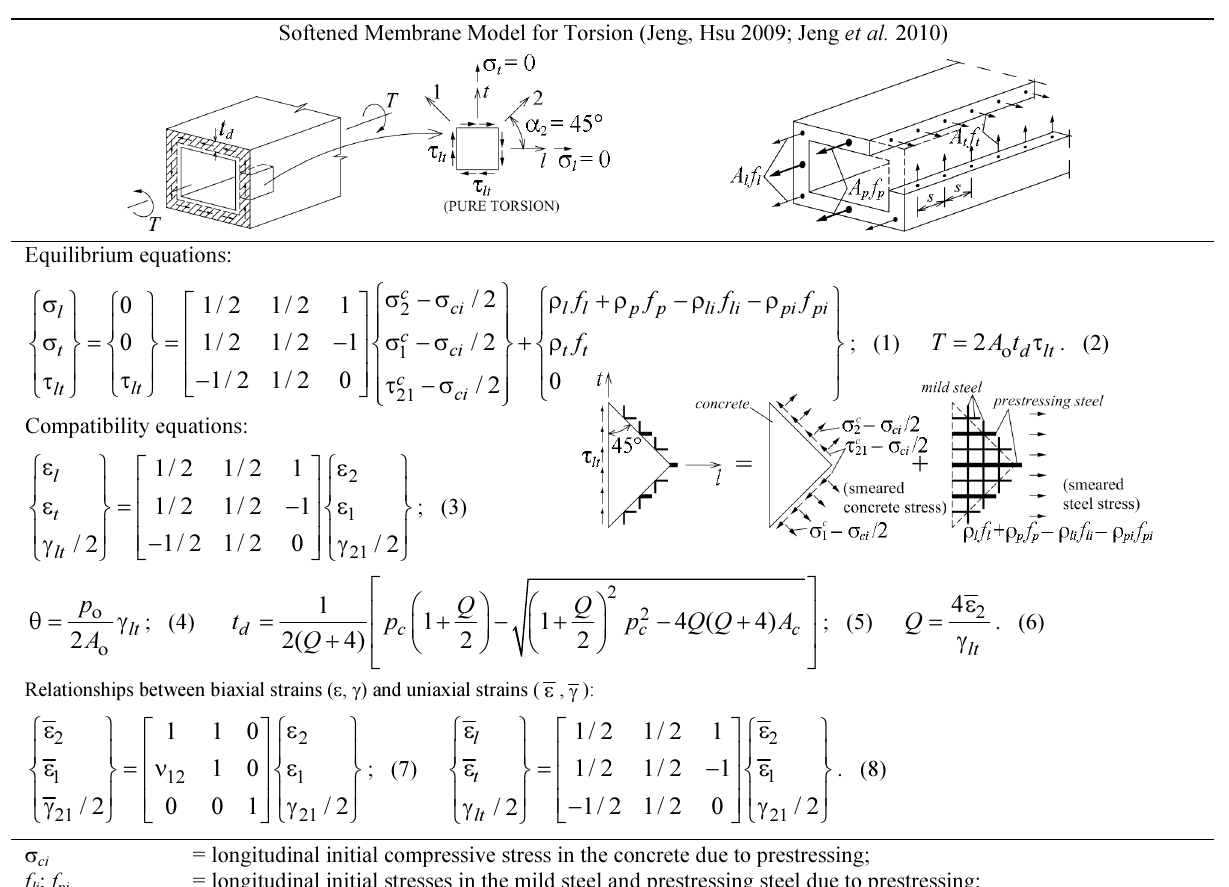
= = σ = ) Table 1. SMMT formulation for PC beams (for RC beams: 0 li pi ci f f Softened Membrane Model for Torsion (Jeng, Hsu 2009; Jeng et al. 2010)